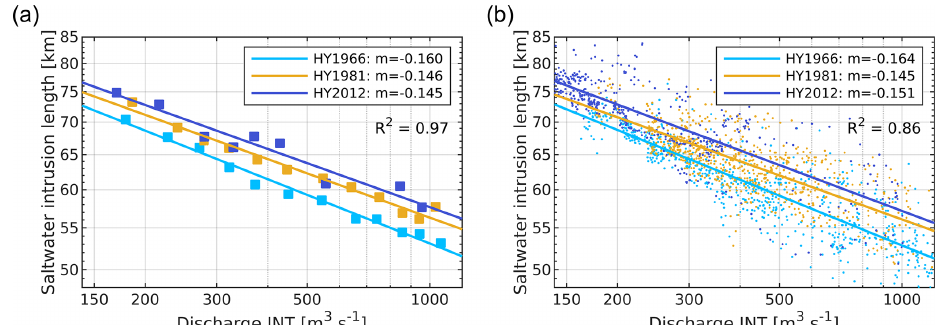
Figure 6. Saltwater intrusion length L ∗ (distance from the estuary mouth at Weser-km 126.2, see Fig. 1, along the navigation channel to the tide-averaged 5psu isohaline) in hindcast models of 1966, 1981, and 2012, in relation to discharge Q measured upstream of Bremen weir at the Intschede (INT) station. On the left, squares represent the average saltwater intrusion length for different discharge categories and lines represent trends of the form L ∗ = kQ m . With logarithmic scales, m represents the gradient of the lines (a) . The analysis was repeated with non-aggregated data points to test the method’s validity (b) .